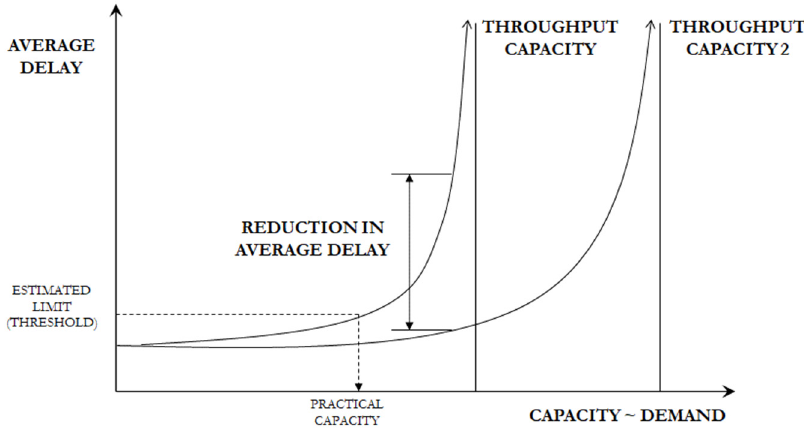
Figure 11. Varying relationship by increasing capacity.